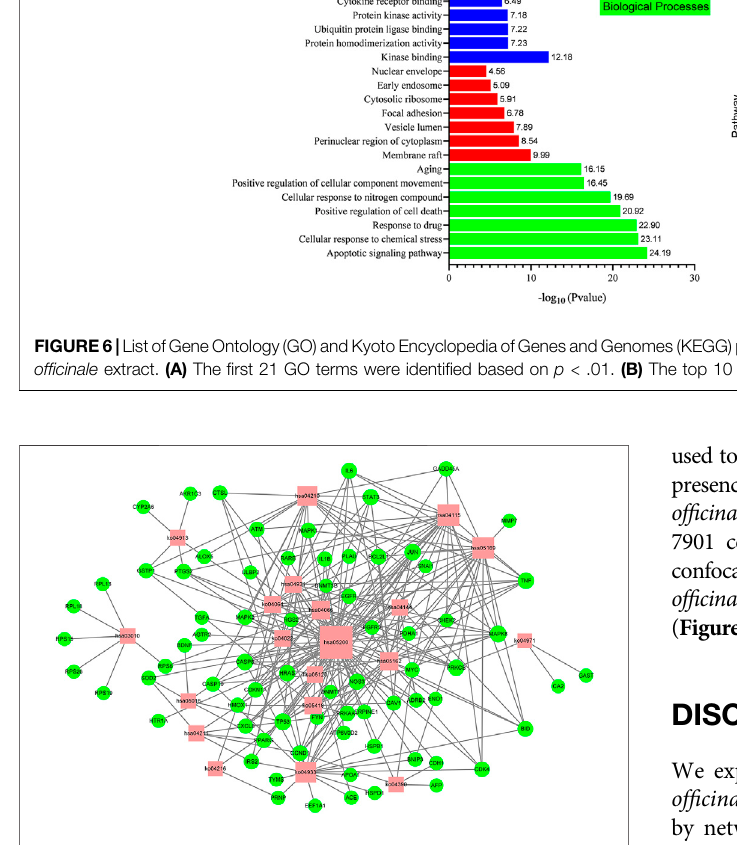
FIGURE 7 | Target-pathway network of the D. of fi cinale extract. The red nodes represent the pathways, and the green nodes represent the targets. The size of the nodes is proportional to the degree of the